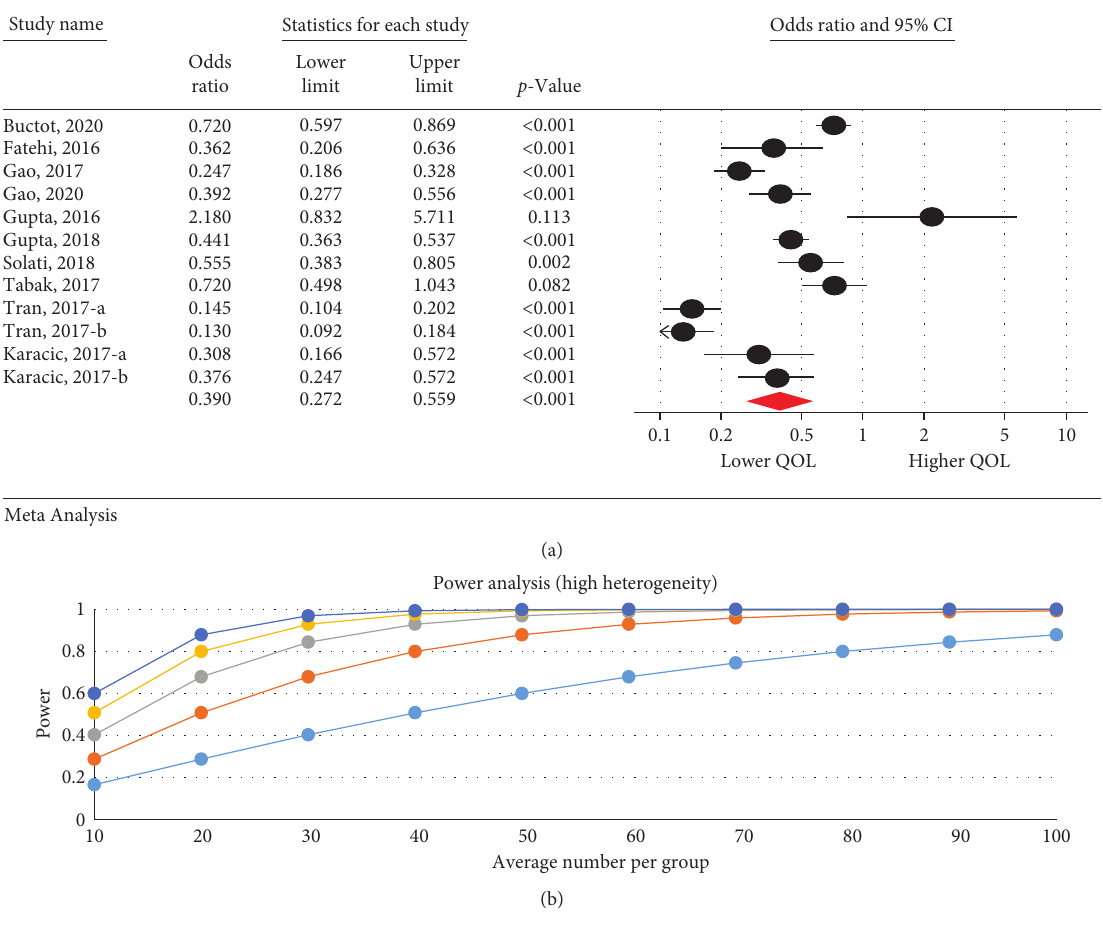
Figure 5: The relationship between the severity of internet addiction and the overall quality of life